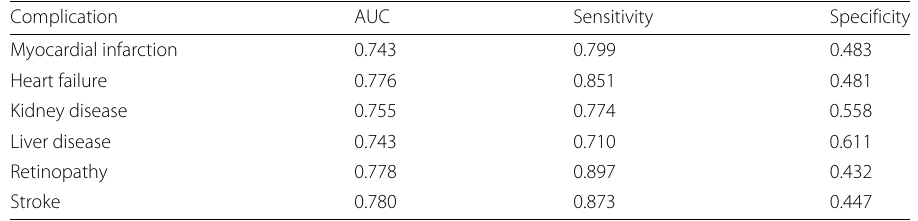
Table 8 Average AUC value, specificity, and sensitivity after five experiments Complication